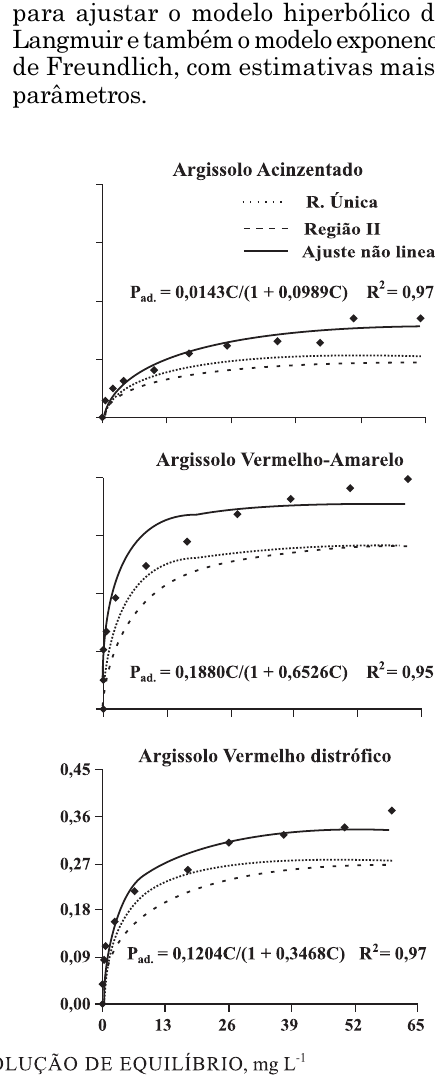
Figura 1. Ajuste do modelo hiperbólico da isoterma de adsorção de Langmuir por meio de ajuste de regressão não linear e da linearização do modelo hiperbólico (região única e região II), para a quantidade de P adsorvida (P ) nos solos mais intemperizados representativos do Estado da Paraíba, como variável da ad. concentração de P na solução de equilíbrio